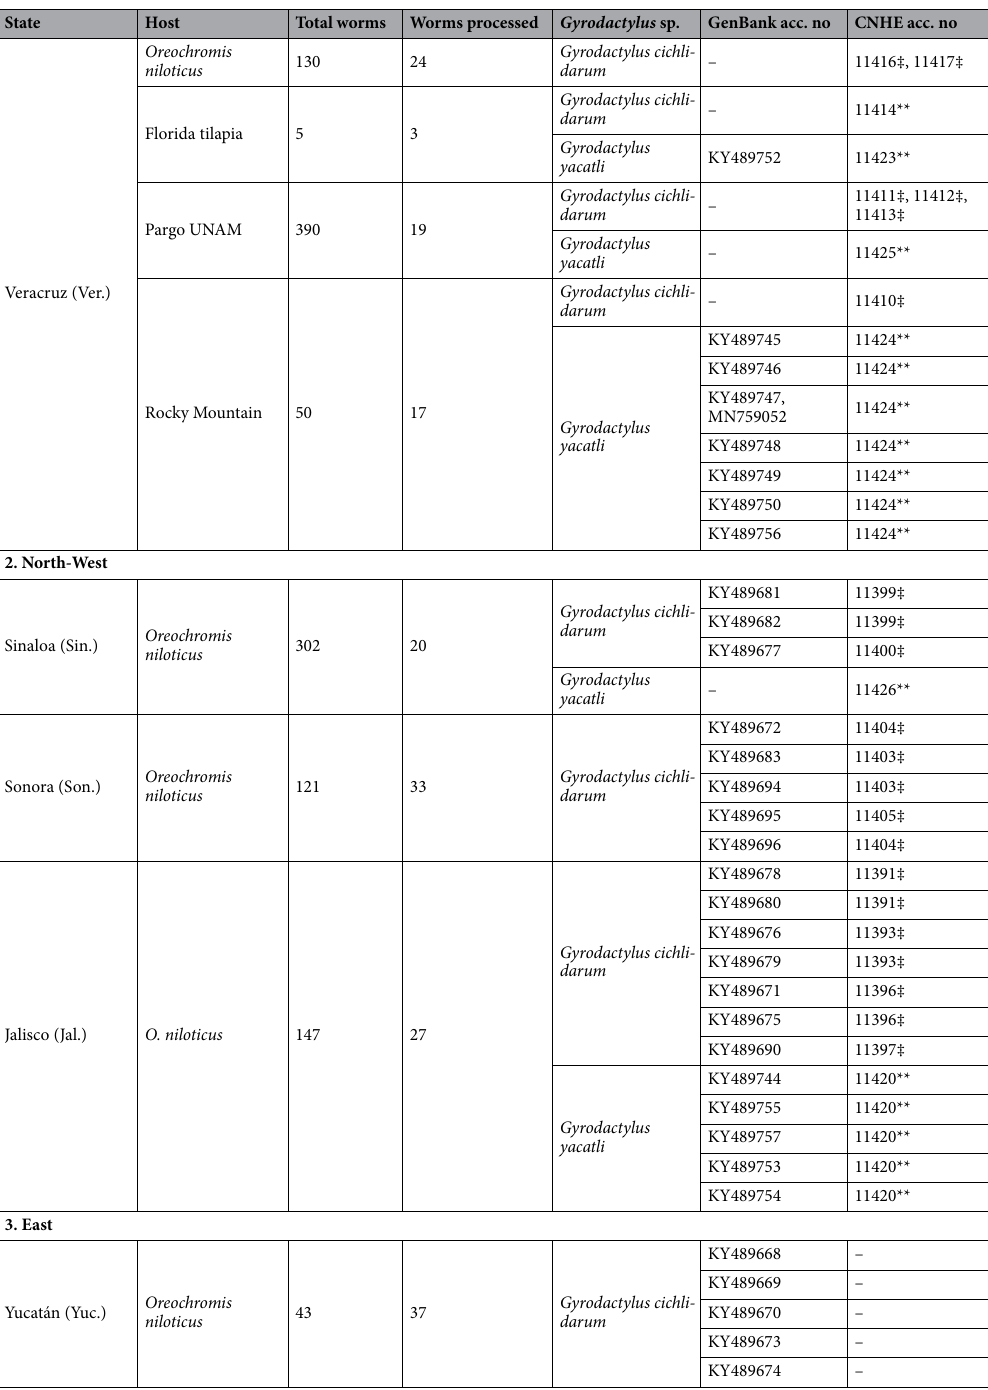
Table 1. An overview of the cichlid fishes examined from “tilapia” farms in Mexico where Oreochromis niloticus (different strains) and native fish were sampled, and from where gyrodactylids were collected and identified taxonomically. Oreochromis PARGO-UNAM is a variety of 25% Rocky mountain (hybrid of O. aureus Steindachner x O. niloticus ) and 25% red variant O. niloticus and 50% Florida red tilapia